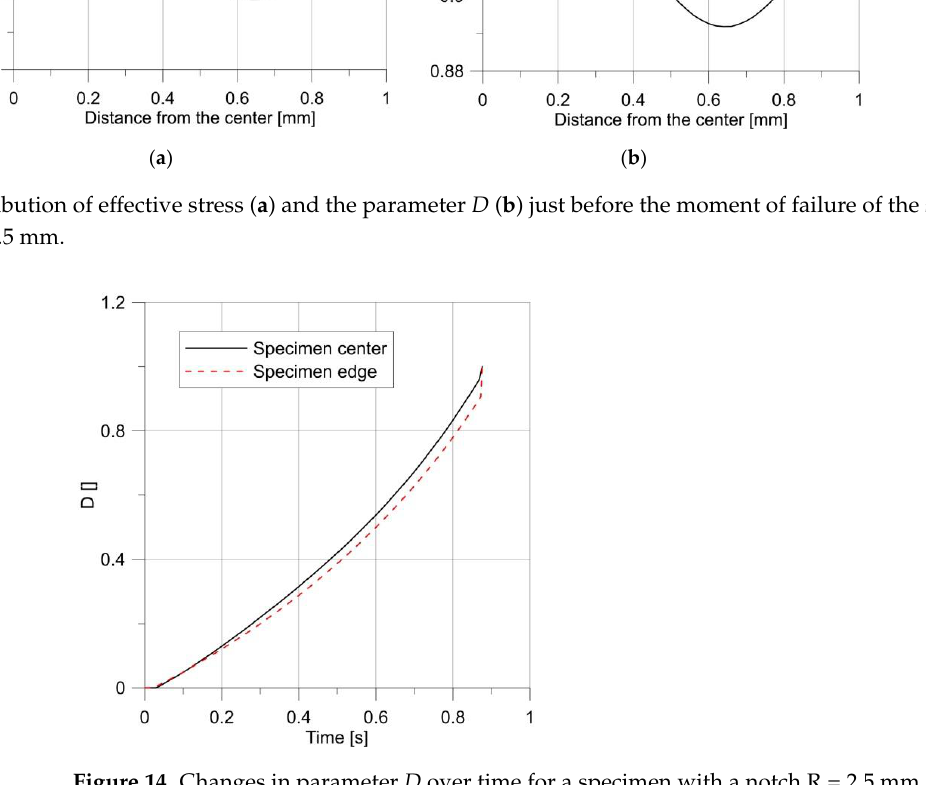
Figure 14. Changes in parameter D over time for a specimen with a notch R = 2.5 mm.